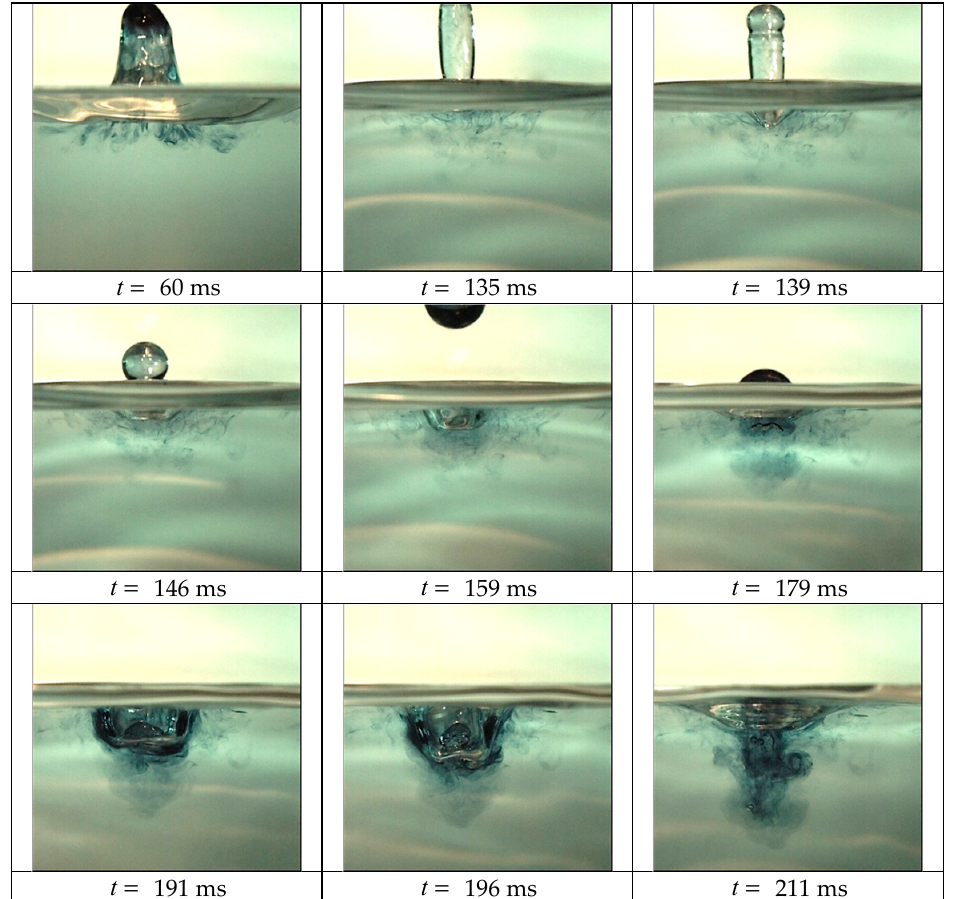
Figure 10. Side view of the impact flow produced by falling drop of an aqueous ink solution diluted at ratio 1:100 coalescing with tap water ( D = 4.3 mm, U = 3.1 m/s, E σ = 4 mkJ, E k = 200 mkJ, Re = 13,300, Fr = 230, We = 570, Bo = 2.5, Oh = 0.0018, R E = E k / E σ = 50, R W = 7 × 10 − 5 , shooting speed 4000 fps).